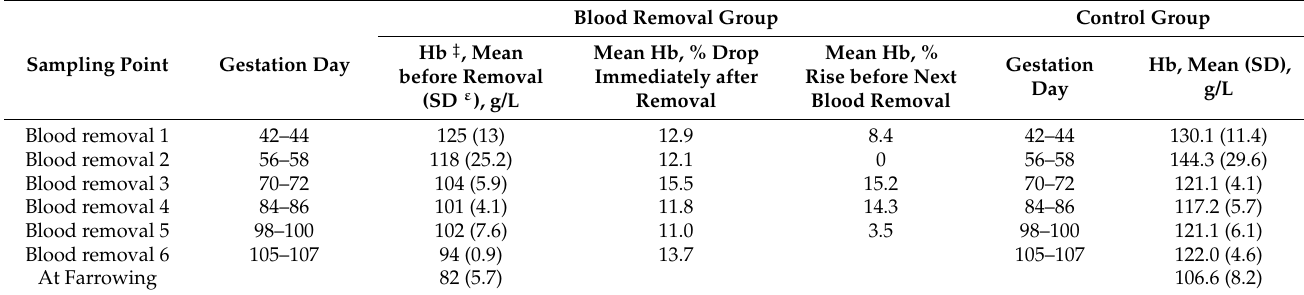
Table 3. Hemoglobin levels on blood removal days and at farrowing in trial II.